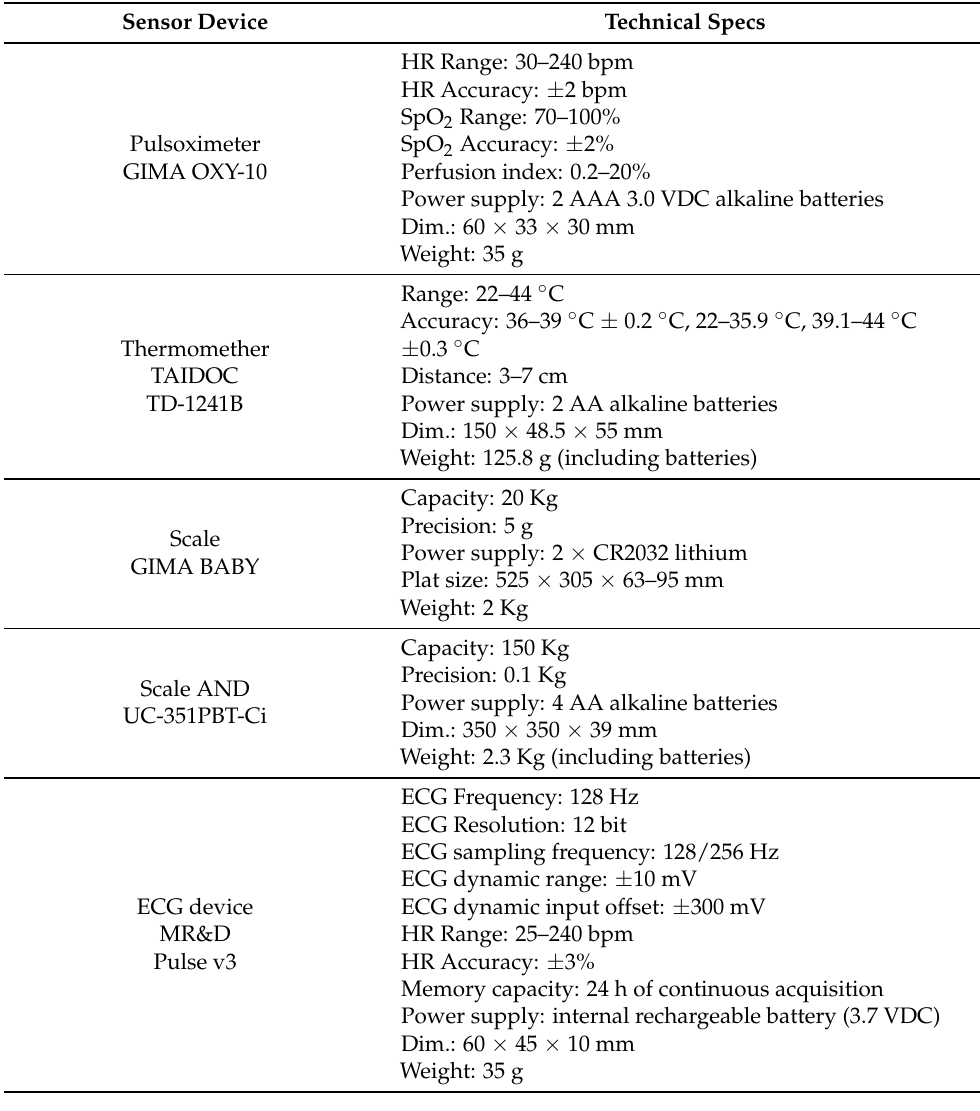
Table 1. Technical specifications of the sensor devices.